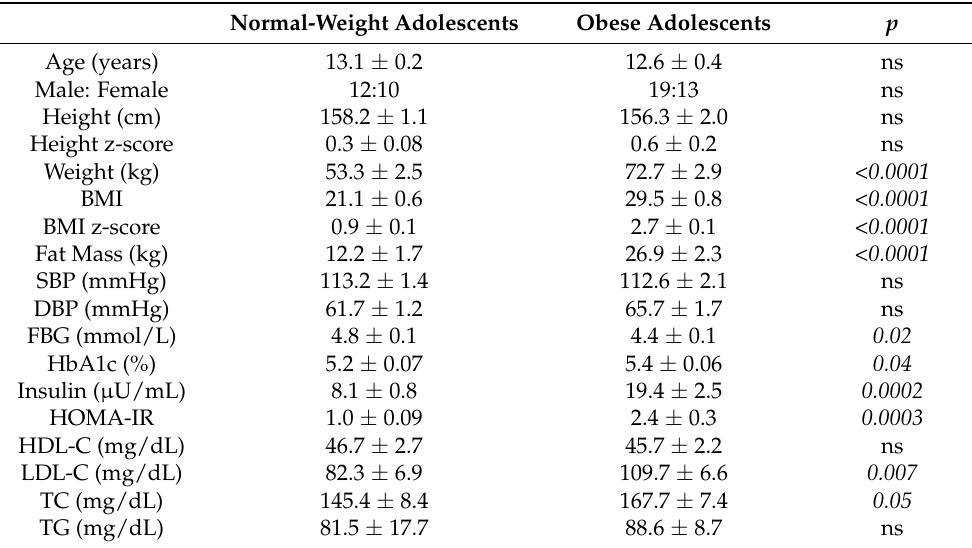
Table Legend. All data are expressed as mean ± SEM. BMI: body mass index; SBP: Systolic Blood Pressure; DBP: Diastolic Blood Pressure; FBG: Fasting Blood Glucose; HbA1c: glycated hemoglobin; HOMA-IR: HOmeostatic